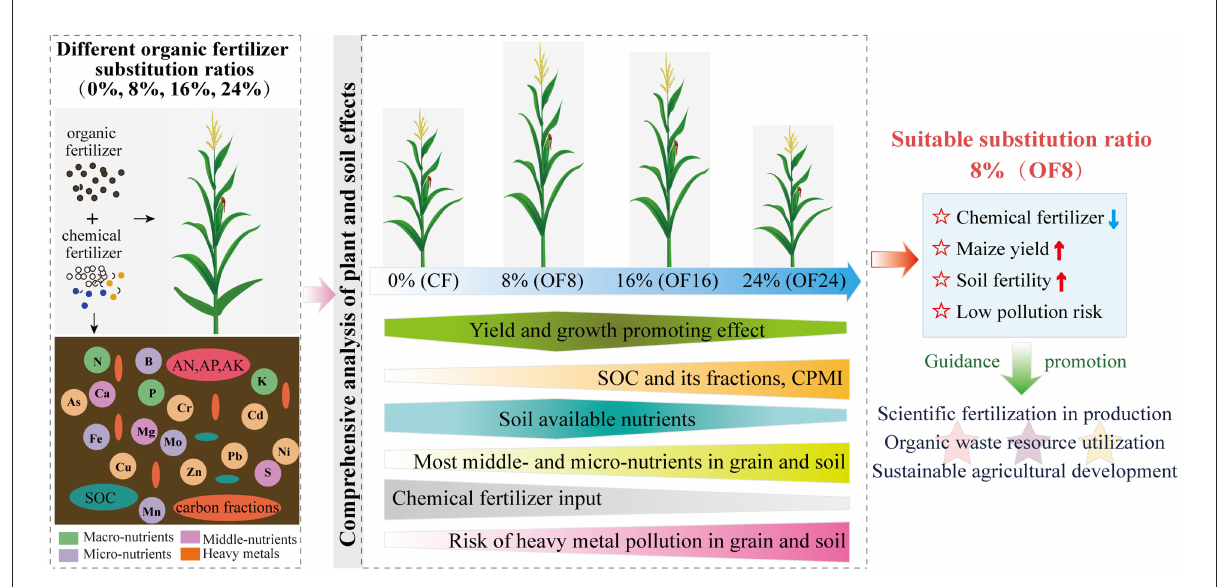
FIGURE6 Framework for determination of a suitable substitution